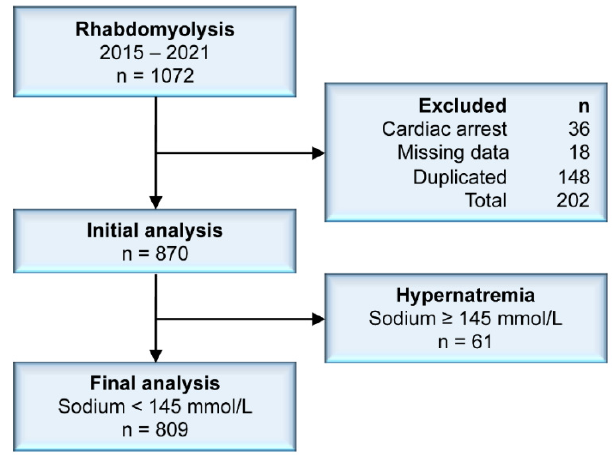
Figure 1. Study flow diagram. Note: sodium corrected for glucose levels.